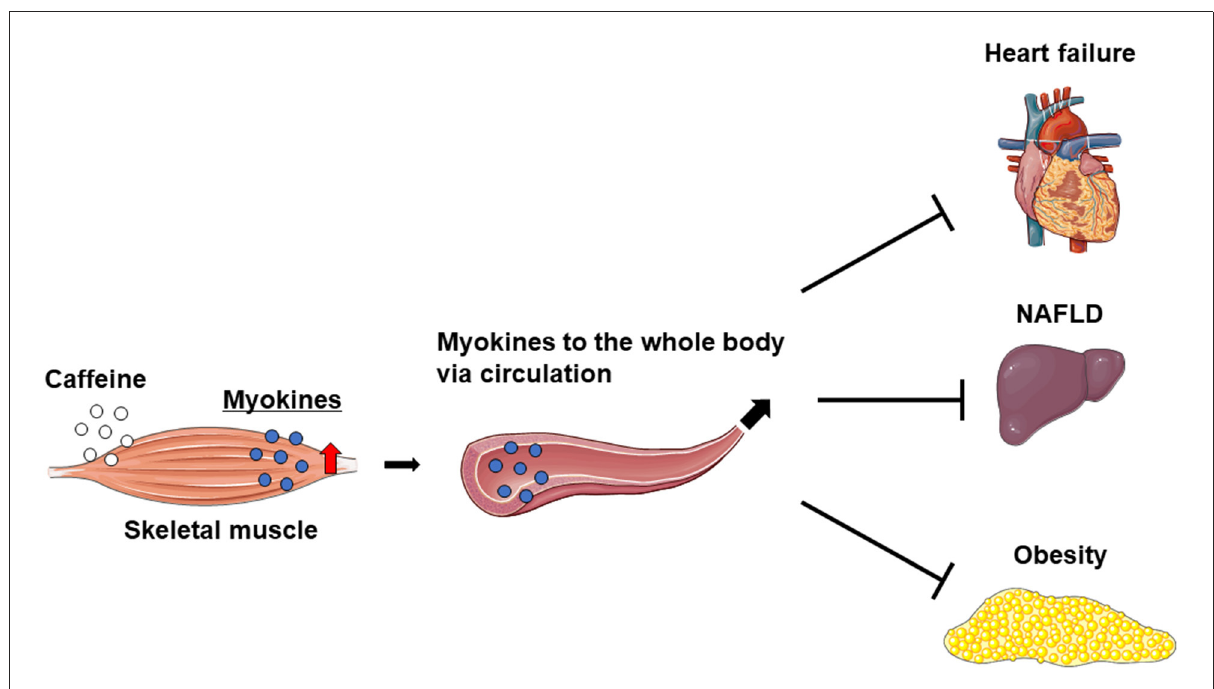
FIGURE2 Increased myokines in skeletal muscle may improve heart failure, NAFLD, and